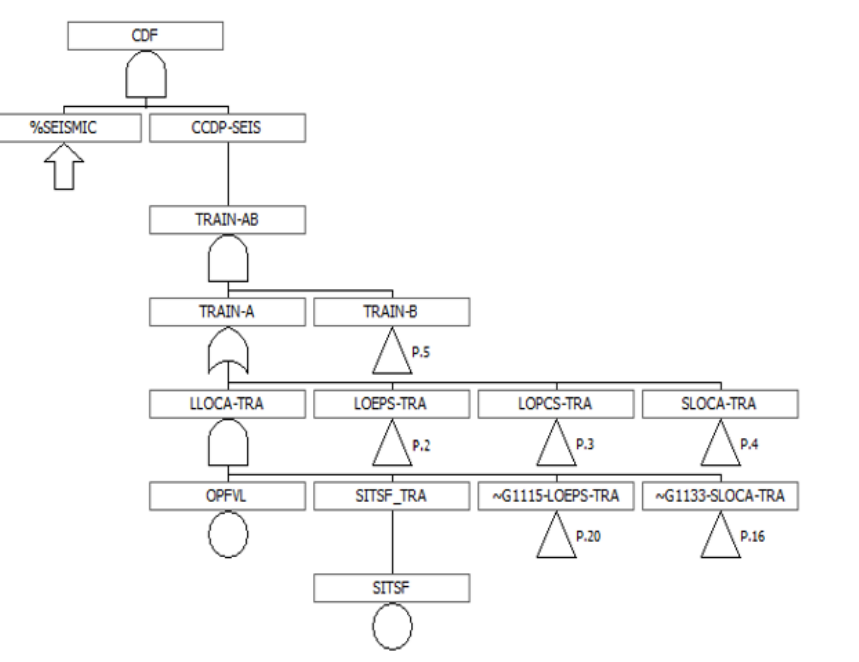
Figure 8. SUCDF fault tree (Model A).